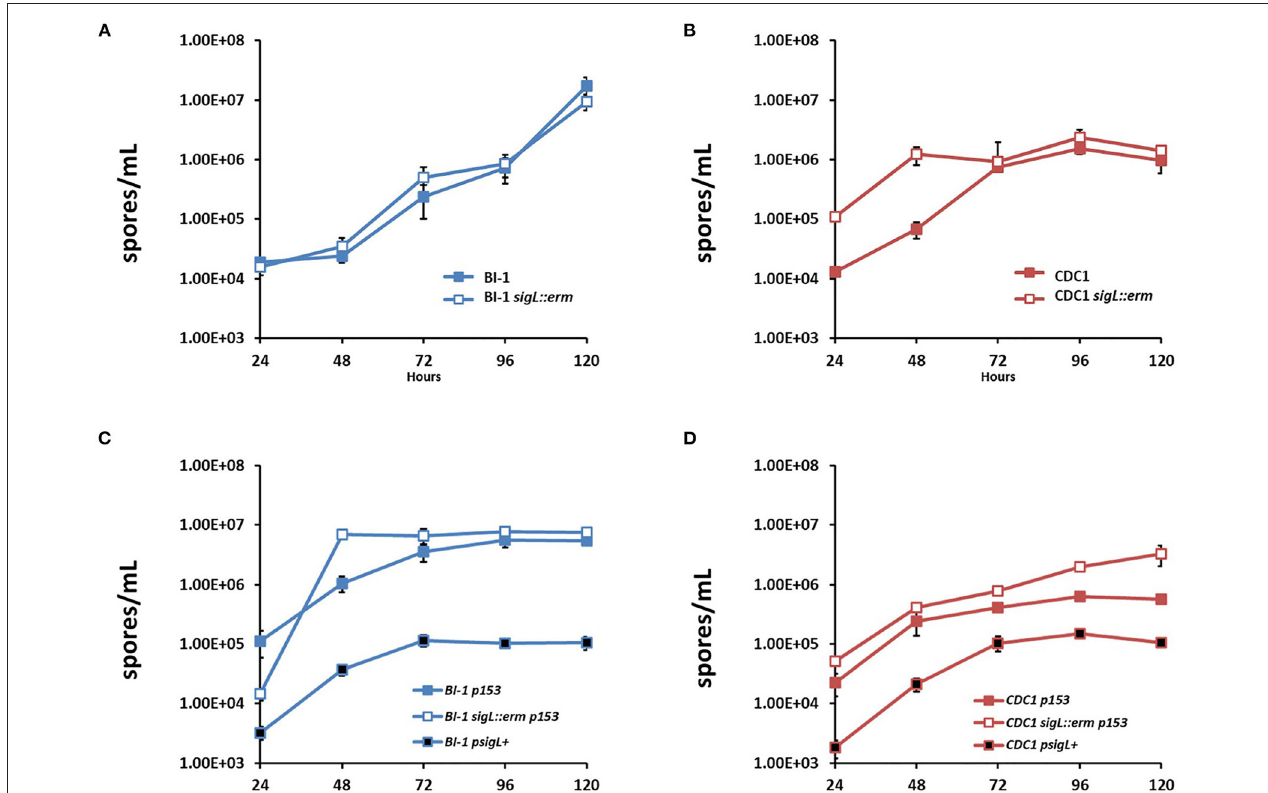
FIGURE 8 | Sporulation kinetics are altered in sigL::erm in a ribotype-dependent manner. Spores were enumerated by heat shocking and plating cultures on BHIS-Taurocholate at each time point. For overexpression, WT C. difficile strains were conjugated with empty vector pMTL82153 (p153). sigL::erm in BI-1 and CDC1 backgrounds were conjugated with empty vector or p153 expressing sigL under a constitutive promoter (psigL + ). (A) Spore enumeration over 120h in BI-1 and BI-1 sigL::erm strains. (B) Spore enumeration over 120h in CDC1 and CDC1 sigL::erm strains. Cultures were grown in biological triplicate. (C) Spore enumeration over